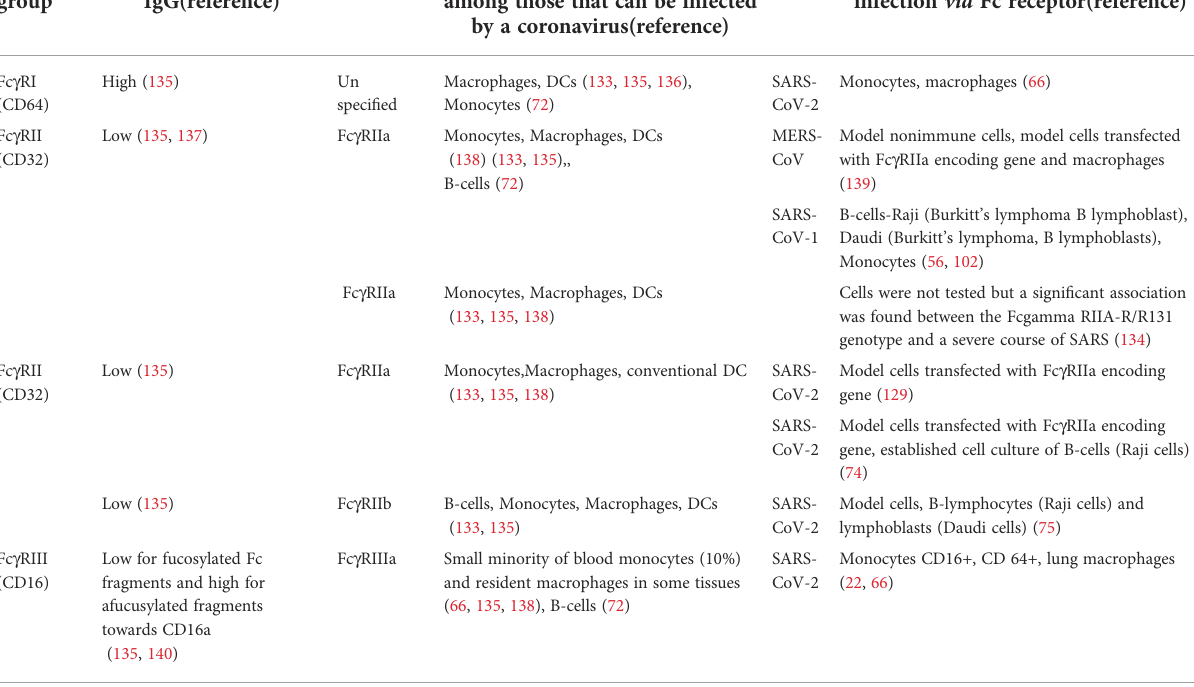
TABLE 2 Fc g Rs receptors involved in the antibody-dependent infection of immune cells by beta-coronaviruses. Receptor Af fi nity to Fc region group